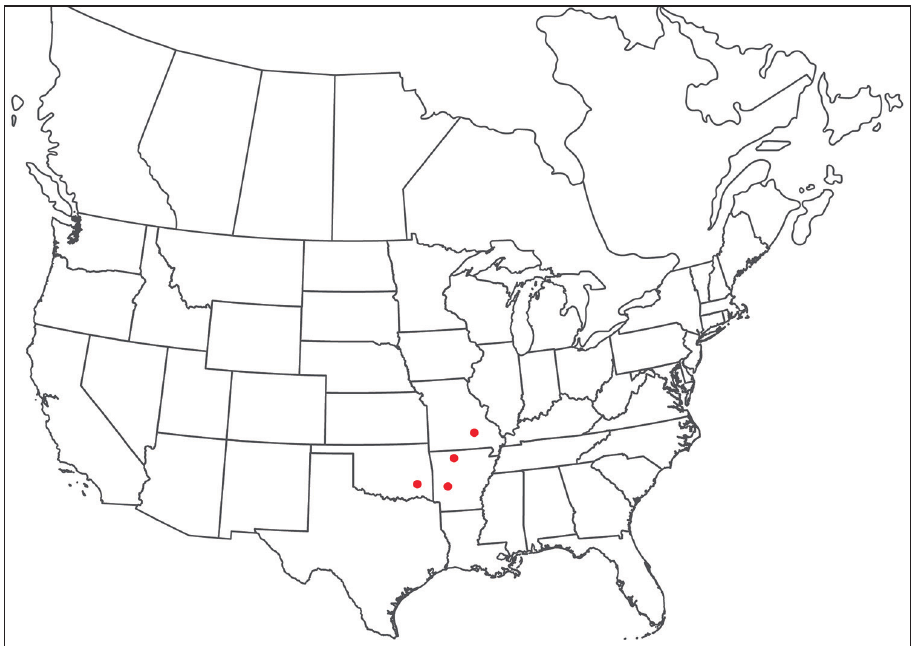
Figure 99. Torrenticola interiorensis sp. n.